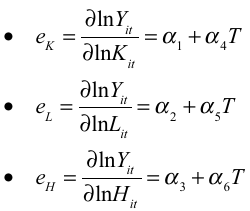
Table 9.0 (Feenstra, Inklaar & Timmer 2015). More precisely, Y, K, L and H are respectively proxied by the variables rgdpna , kna , emp , and H from the Penn World Table.